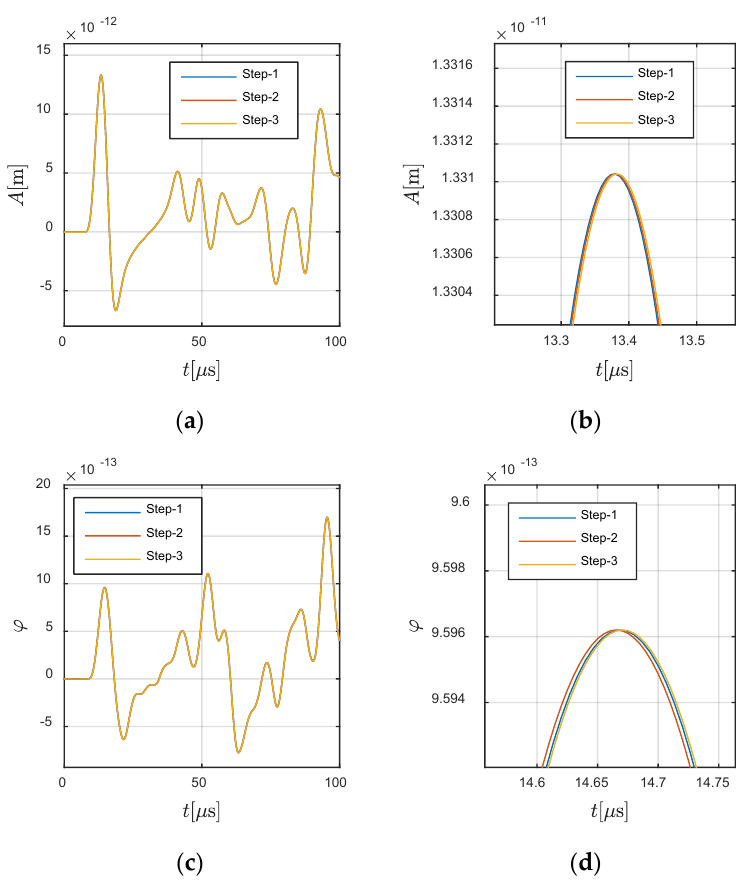
Figure 16. Convergence analysis in time domain: ( a , b ) in solid region, ( c , d ) in fluid region. ( b , d ) are the local views of ( a , b ).